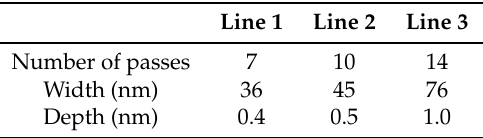
Table 1. Dependence of width (FWHM – Full Width at Half Maximum) and depth of lines on the number of passes (in Figure 4b, from left to right). Data are averaged from 256 profile lines. Line 1